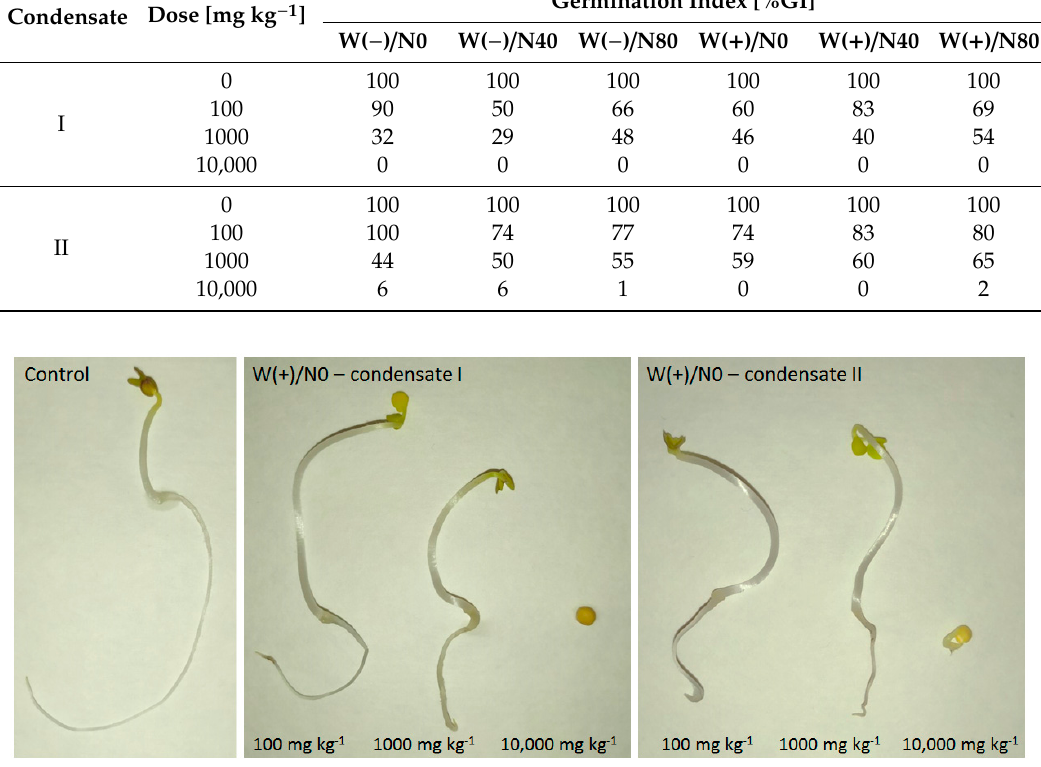
Figure 12. Phytotoxic effect of condensate components I and II on seed germination and root elongation in W(+)/N0 object in relation to control.